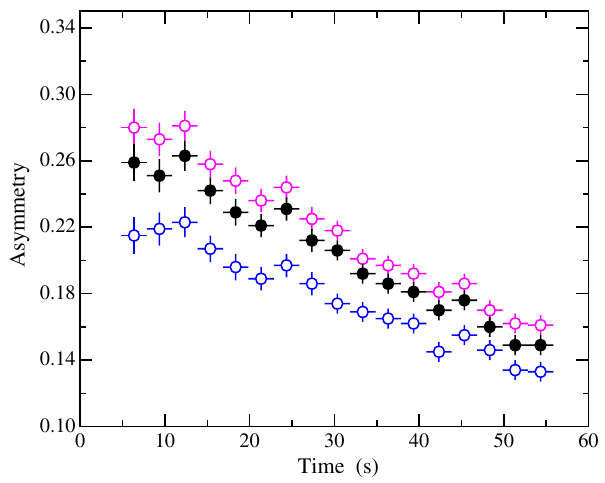
FIG. 8. Measurements of the magnitude of the horizontal polarization asymmetry as a function of the time during the data-taking portion of the machine cycle. The black points were analyzed using a fixed spin tune. The magenta points show the largest value of the magnitude when the spin tune value is allowed to vary from bin to bin. If a poor choice is made for the spin tune in the fixed tune analysis and the phase changes by 20 – 30 radians during the machine cycle, then there is smearing in the time bins which results in a smaller fitted magnitude, as shown by the blue points. Note the suppressed zero on the vertical